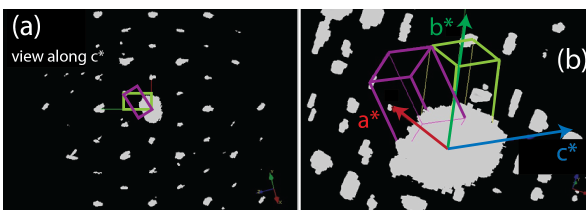
Figure 8. 3D reconstruction of electron diffraction data taken from twins in zhiqinite near point no. 429 in foil no. 5358 (Fig. 3). (a) View along c ∗ , which is the axis of rotation for the twins (green and purple rectangles). (b) Tilted view showing c ∗ , which is com- mon to both twins, as well as a ∗ and b ∗ in the twin outlined in yellow green.